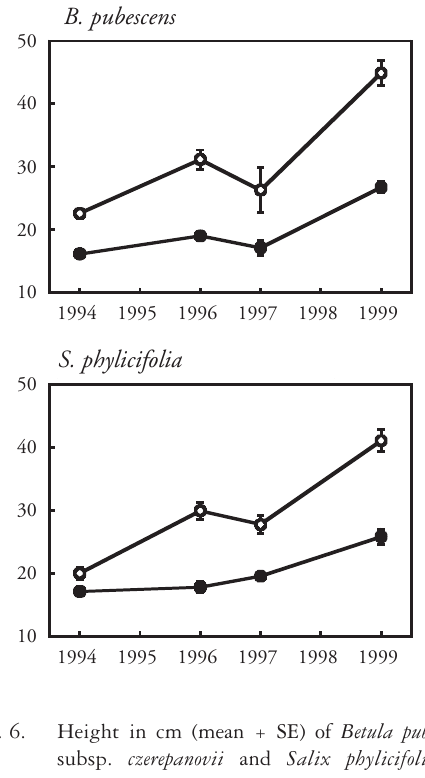
Fig. 6. Height in cm (mean + SE) of Betula pubescens subsp. czerepanovii and Salix phylicifolia in browsed and unbrowsed